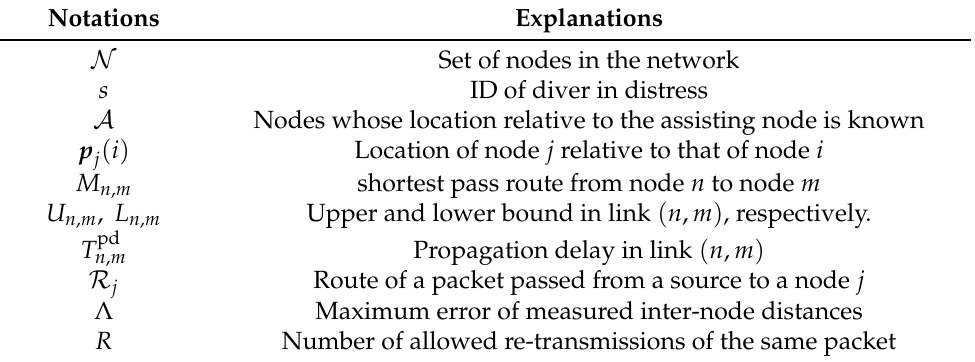
Table 1. List of major